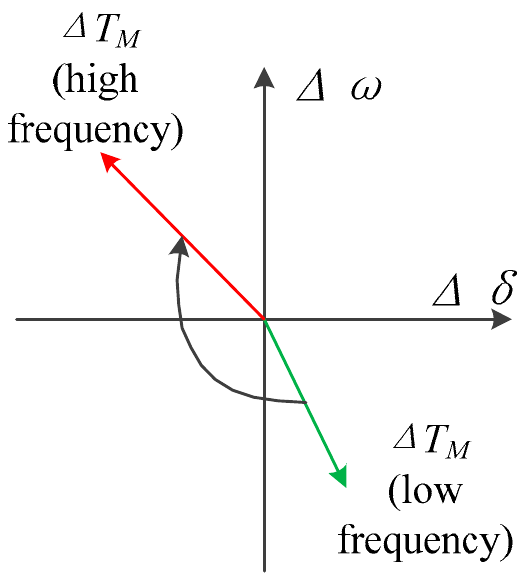
Figure 2. Location of the change in hydroturbine torque ( ∆ T M ) in opening regulation mode (ORM). In a low-frequency region, ∆ T D is in same direction as − ∆ ω . The regulation of the governor provides positive damping and improves system stability. In a high frequency region, ∆ T D is in the same direction as − ∆ ω . The regulation of a governor provides negative damping and worsens system stability. With increasing T W , the critical frequency ω 1 decreases and system stability